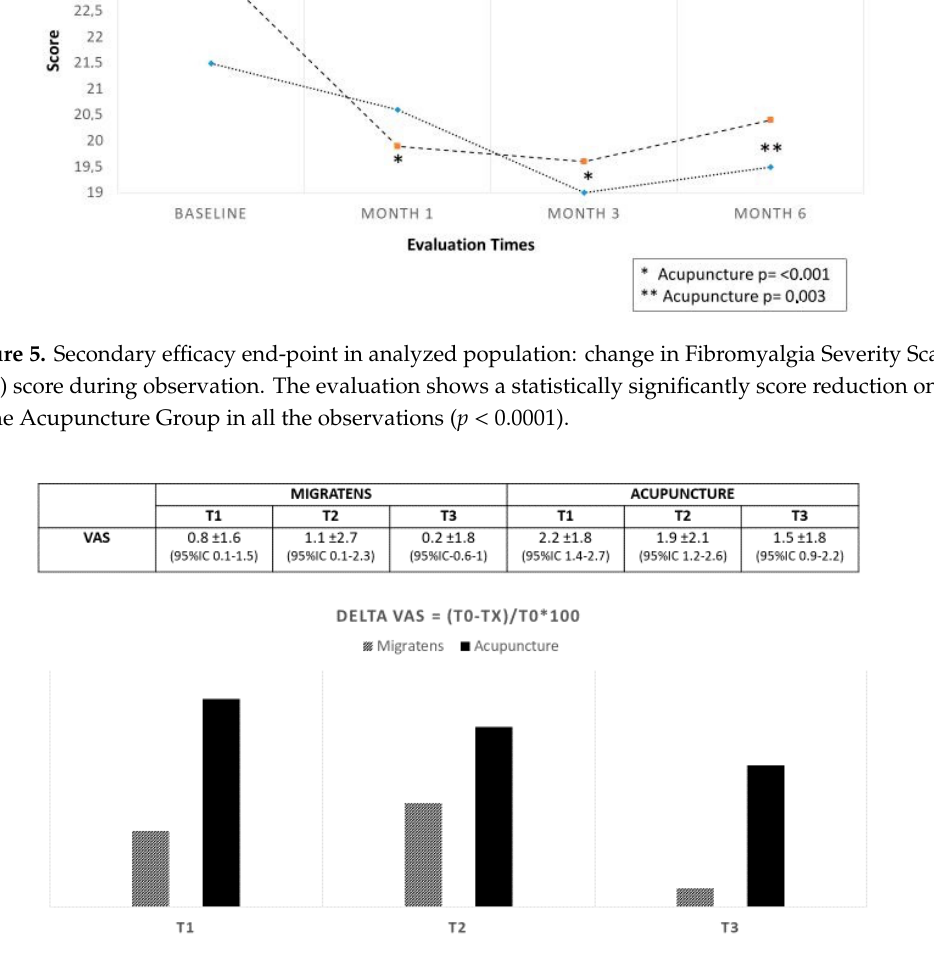
Figure 7. Reduction difference in FIQ-R values in the two treatment groups during observation (values are expressed as mean difference ± SD).